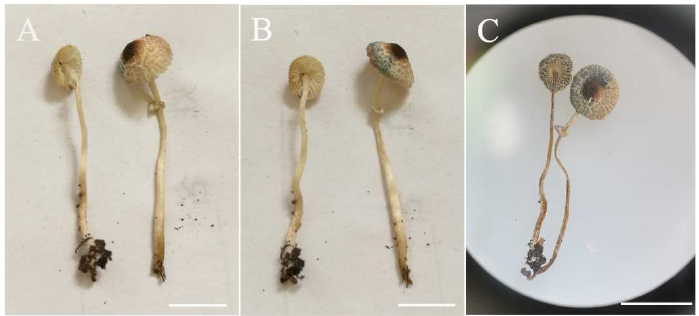
Figure 12. Basidiomata of Leucoagaricus virens . ( A – C ) CFSZ 19869. Scale bars: 1 cm.